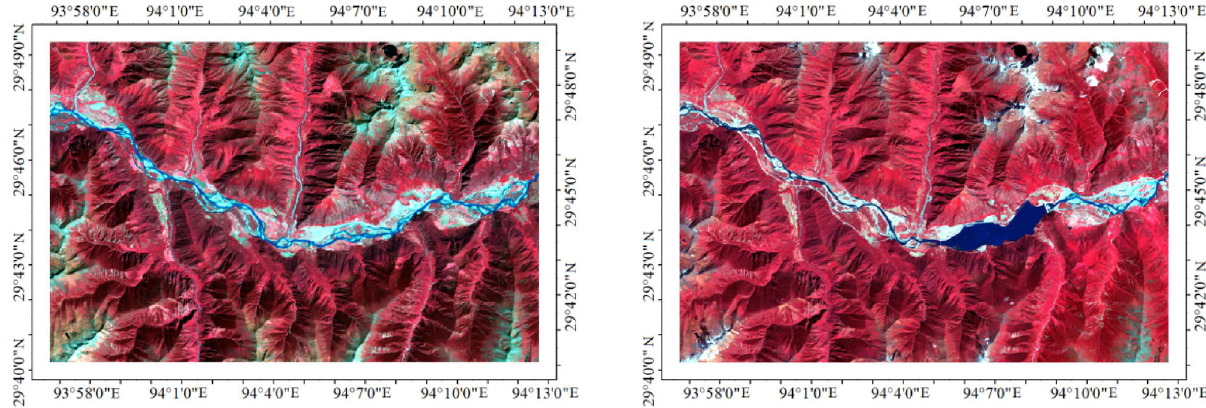
Figure 10. Remote sensing images of the study area. The images can be obtained from the websit of the USGS (http:// glovis. usgs. gov/). The figure is generated using ArcGIS 10.3 (http:// www. esri. com/ softw are/ arcgis/ arcgis- for- deskt